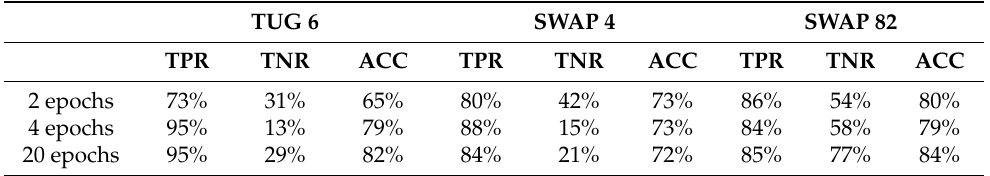
Table 6. Sensitivity (true-positive rate, TPR), specificity (true-negative rate, TNR), and accuracy (ACC) for the faller classification using the TUG 6, SWAP 4, and SWAP 82 tasks with different number of epochs in ANN learning (averaged over number of neurons and regularisation approach).